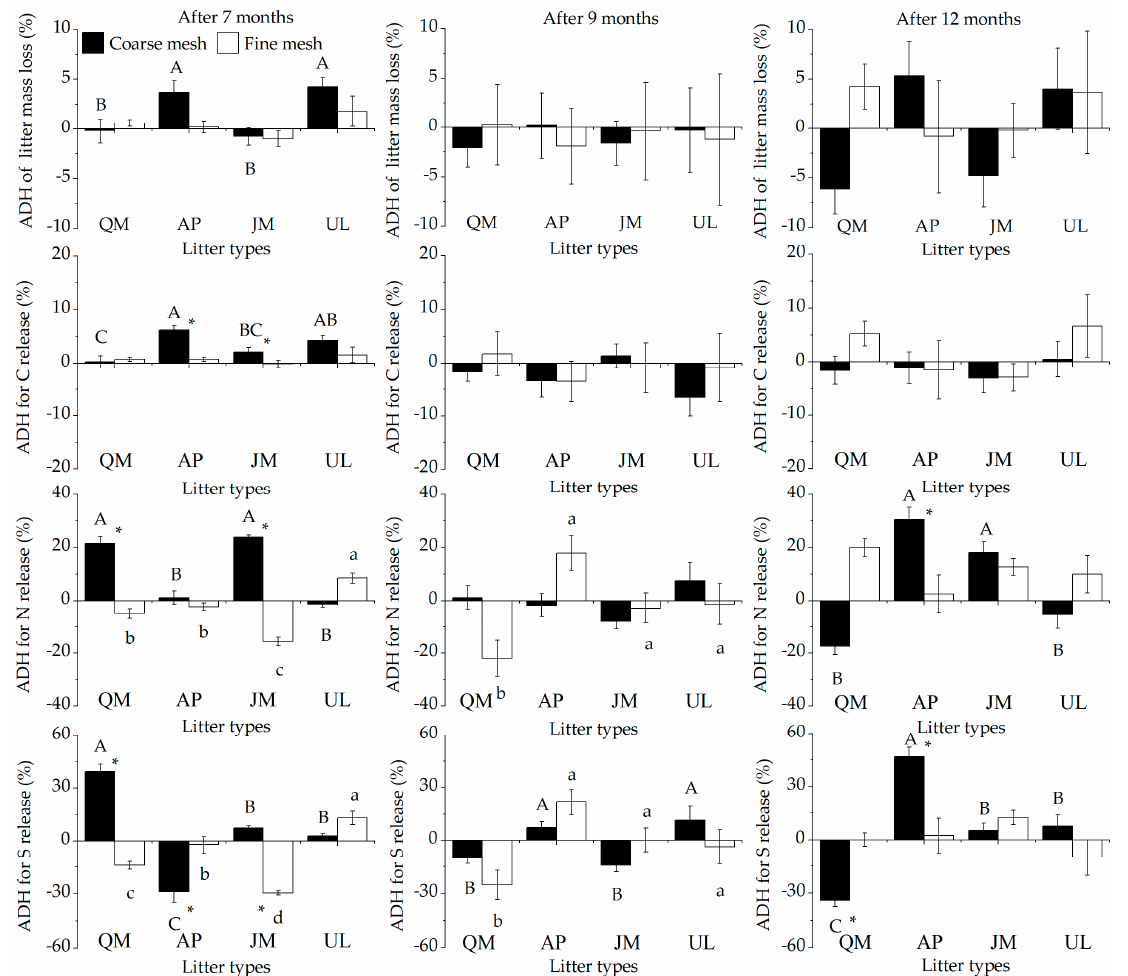
Figure 2. Mean additional decomposition at home (ADH) of different litter types during the experimental period. Values are the mean ± SE ( n = 3). The asterisk indicates significant differences between the coarse mesh and fine mesh sizes within the same litter types. Different uppercase letters indicate significant differences among litter types in the coarse mesh litterbags within the same experimental period ( p < 0.05). Different lowercase letters indicate significant differences among the litter types in the fine mesh litterbags within the same experimental period ( p < 0.05).